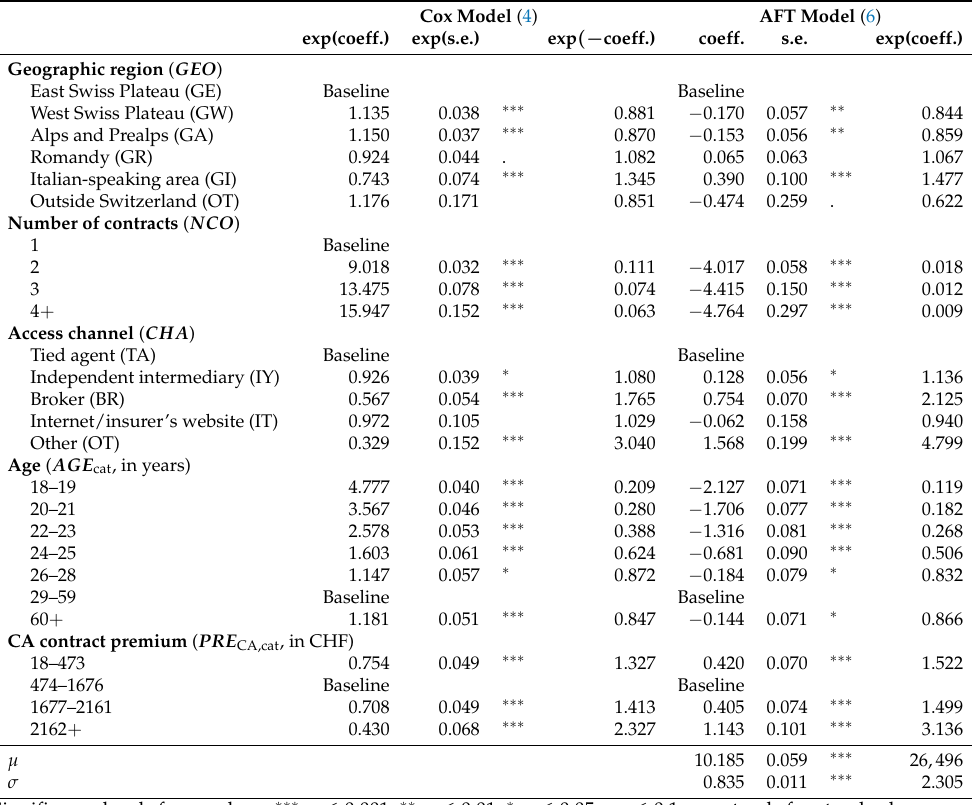
Table 4. Empirical results of the Cox and AFT models (4) and (6) for the CA cohort. Cox Model (4) AFT Model (6) exp(coeff.) exp(s.e.) exp ( − coeff.) coeff. s.e.